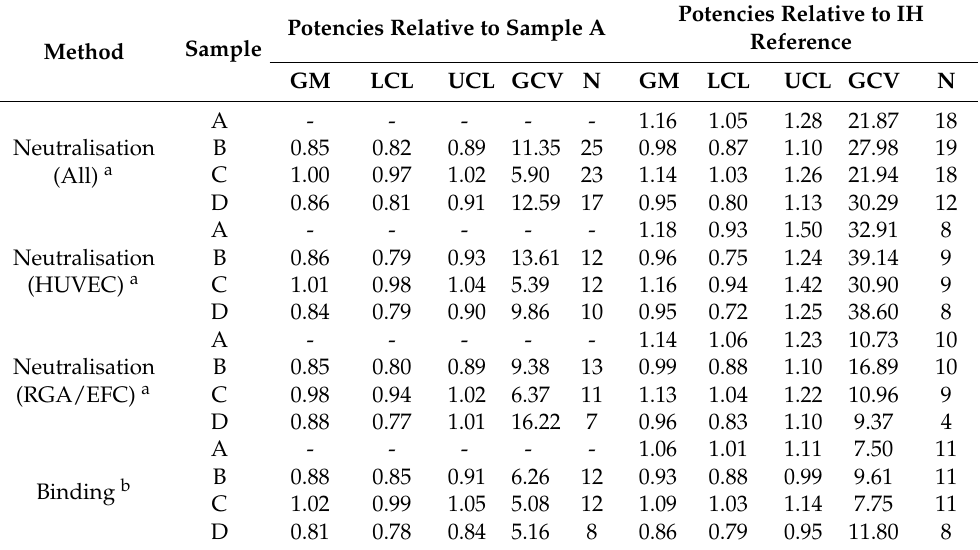
Potencies Relative to IH Reference